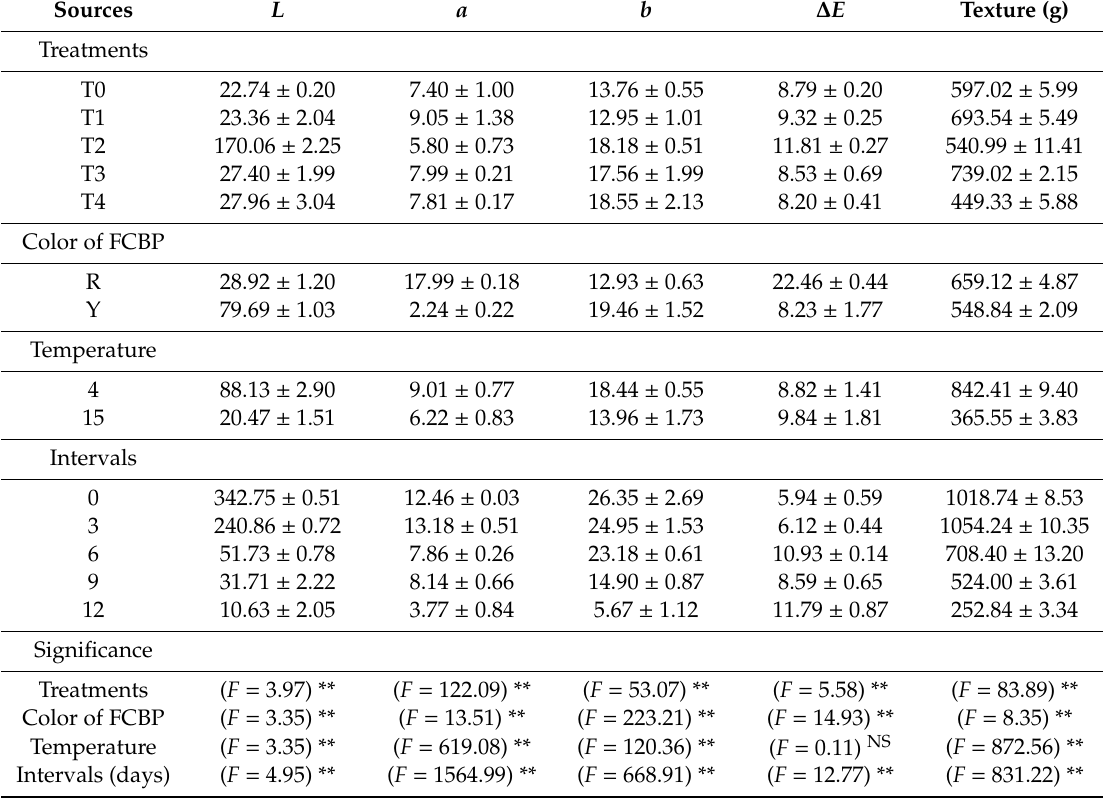
Table 3. Measurement of physical properties of color and textural changes in fresh-cut bell pepper (FCBP) treated or untreated with Lactobacillus rhamnosus GG and biochemical agents at di ff erent time intervals (days) and preserved in two di ff erent temperatures (4 and 15 ◦ C). L : lightness, a : red / green value, b : blue / yellow value, ∆ E : color di ff erence. The results presented the estimated marginal means ± SE. ** significant ( p < 0.01); NS: not